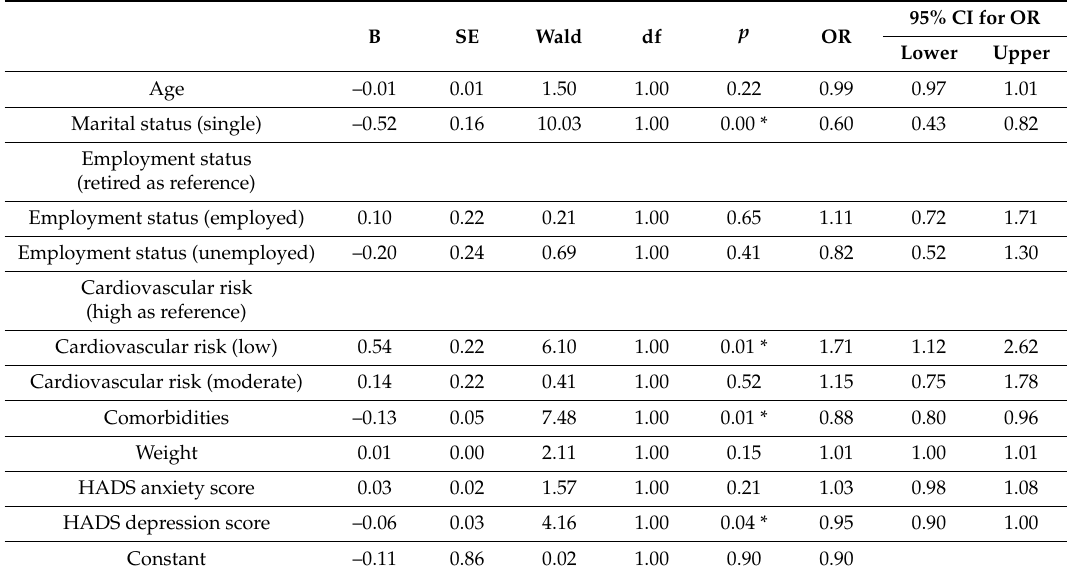
Table 4. Binary logistic regression predicting likelihood of quitting smoking among patients who attended cardiac